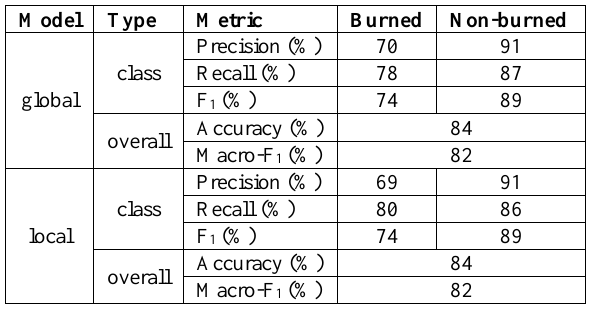
Table 2 . Performance comparison of the global and the local model in Central Africa with predictions based on the Central African test dataset.